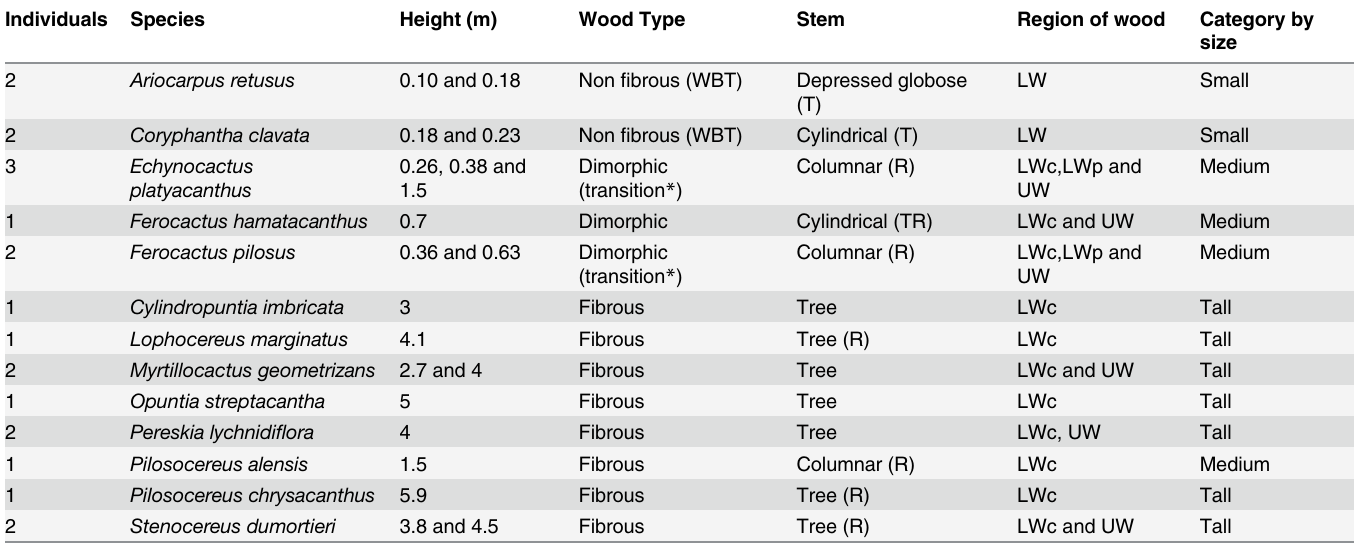
Table 1. Characteristics of individuals studied from thirteen species of Cactaceae, the regions of wood that were studied are indicated. Individuals